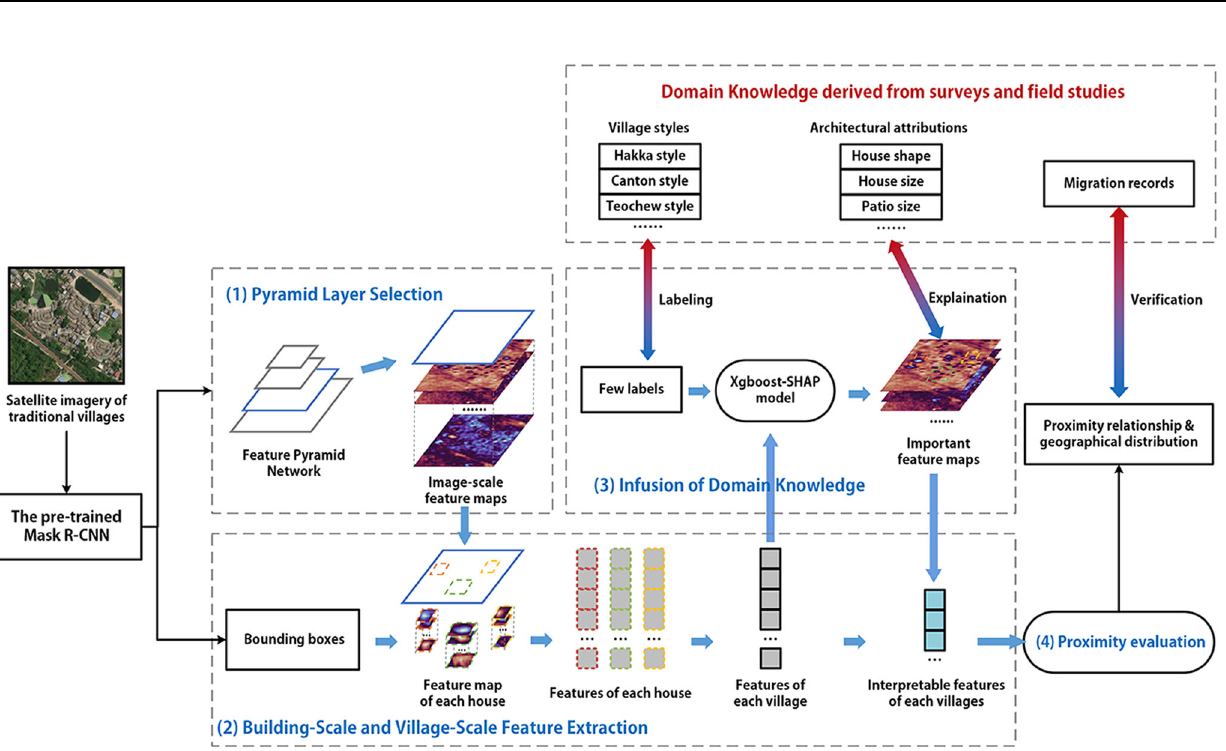
Fig. 2 The work fl ow of the proposed XDR framework. It illustrates how the satellite imagery of a traditional villages is processed to recognize its ethnic style. The XDR framework includes the data-driven part (blue text) and the domain knowledge part (red text). And the red – blue gradient arrows represent the domain knowledge infusion.